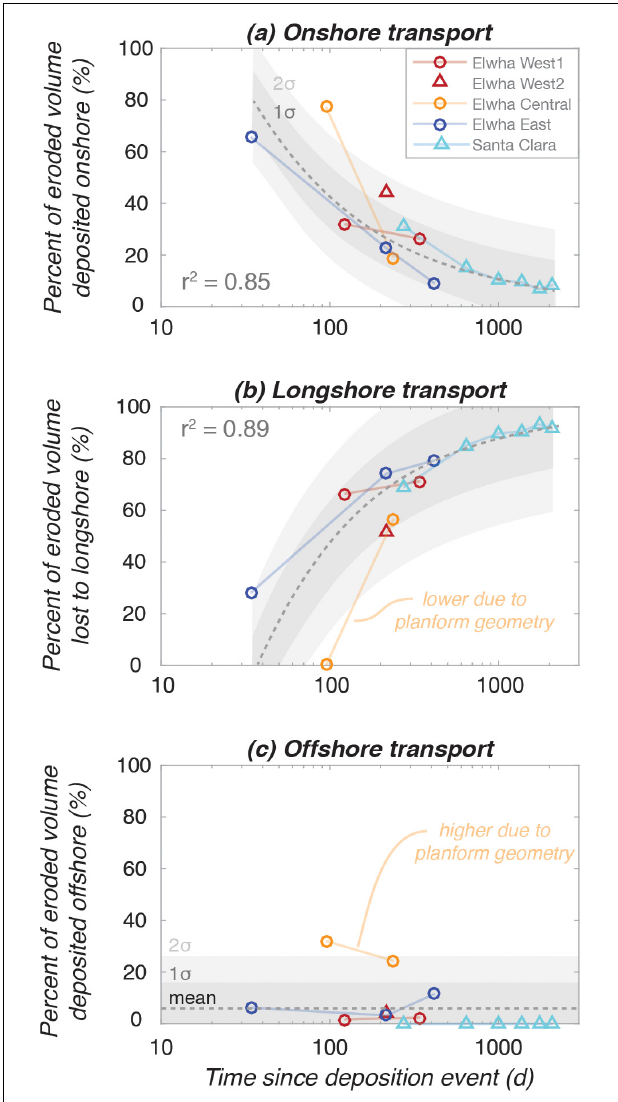
FIGURE 8 | The temporal changes of the sediment volume budgets for the profiles of the Elwha River and Santa Clara River mouths. Data presented as the percent of net erosion for each survey interval that was transported in the following directions: (a) onshore, (b) longshore, and (c) offshore. Dashed line is the expoential fit through (a) and (b) with the corresponding correlation coeficients, and shading shows both one and two standard deviations of variation around the fit. For (c) the dashed line is the mean value (6.1%) and shading shows one and two standard deviations about the